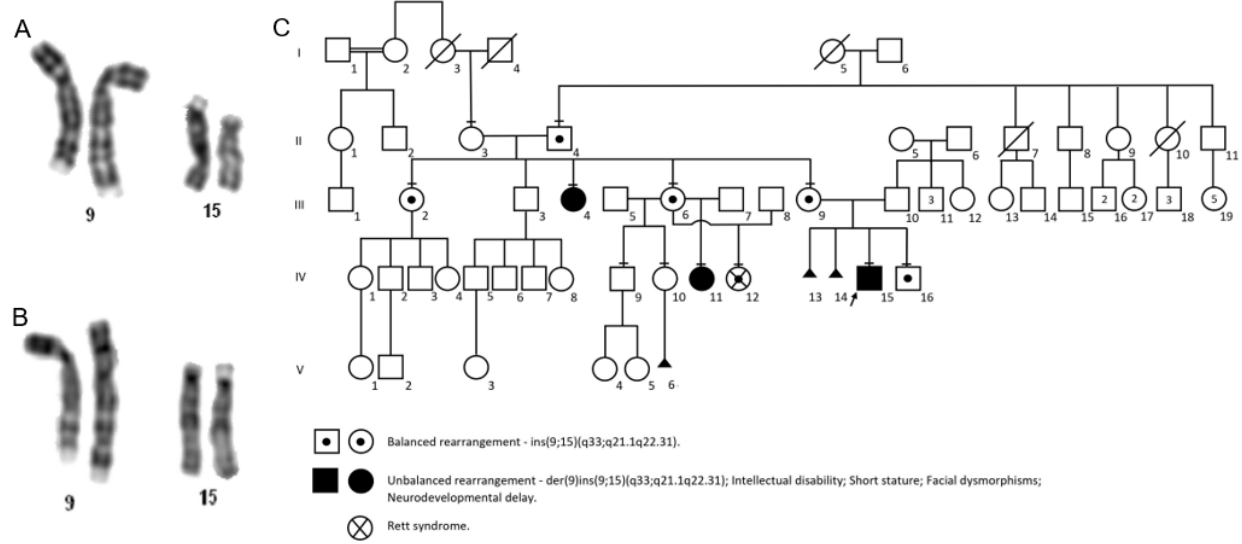
Figure 1. ( A ) Partial G-banded karyotype of chromosomes 9 and 15, balanced insertion